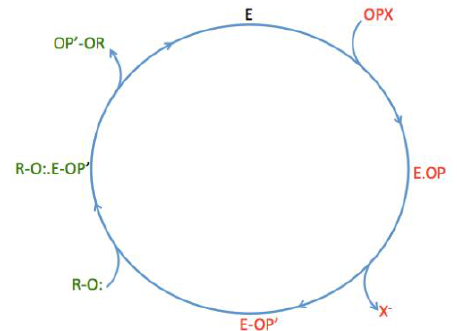
Figure 2. Coupled consecutive reactions between cholinesterase (E) phosphylation (E-OP’) by organophosphate (OPX = T) and oxime (R-O:)-mediated cholinesterase